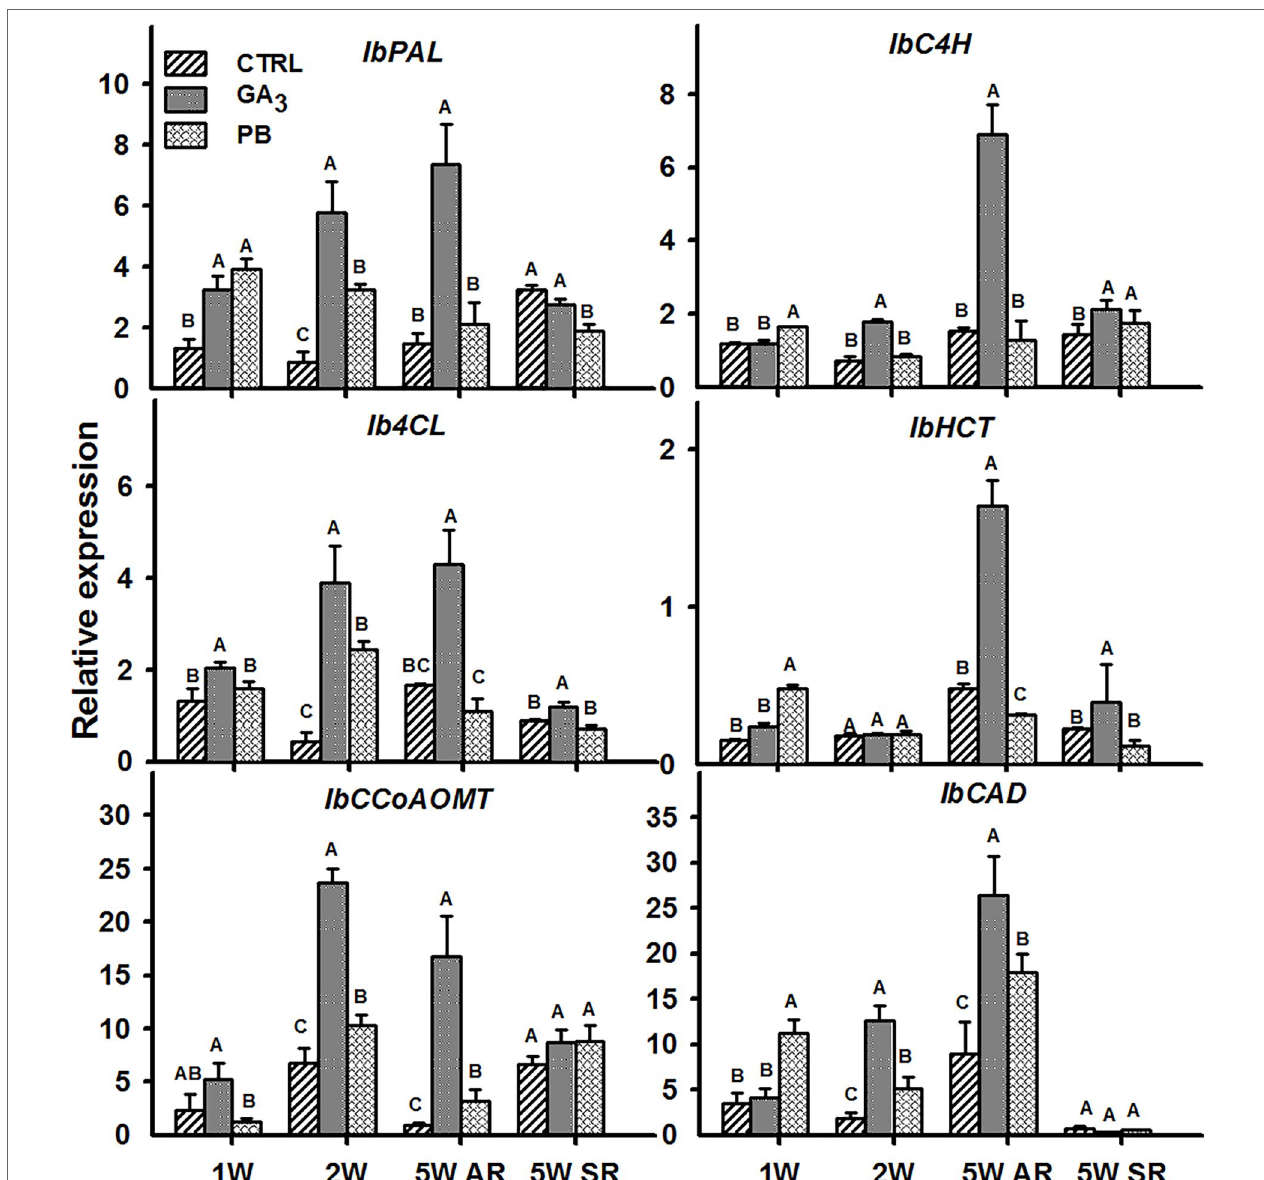
FiGURe 10 | The effect of GA 3 application on expression profiles of sweetpotato “ Georgia Jet ” orthologues/genes of lignin biosynthesis in adventitious roots (AR) and storage-roots (SR). Expression/transcript levels were measured at 1W, 2W, and 5W after planting for AR and at 5W for SR, using qRT-PCR analyses, and values were normalized relative to the expression levels of phospholipase D1a. qRT-PCR data are mean (± SE) of three independent biological replicates (each representing roots pooled from four plants). Significance analysis was performed by using student’s t-test ( P ≤ 0.05 ), where unlike letters represent significant differences between treatments within a group. Control (treated with water); GA 3 , application of 50 ppm gibberellic acid 3 for two weeks; PB, application of 5 ppm paclobutrazol for two